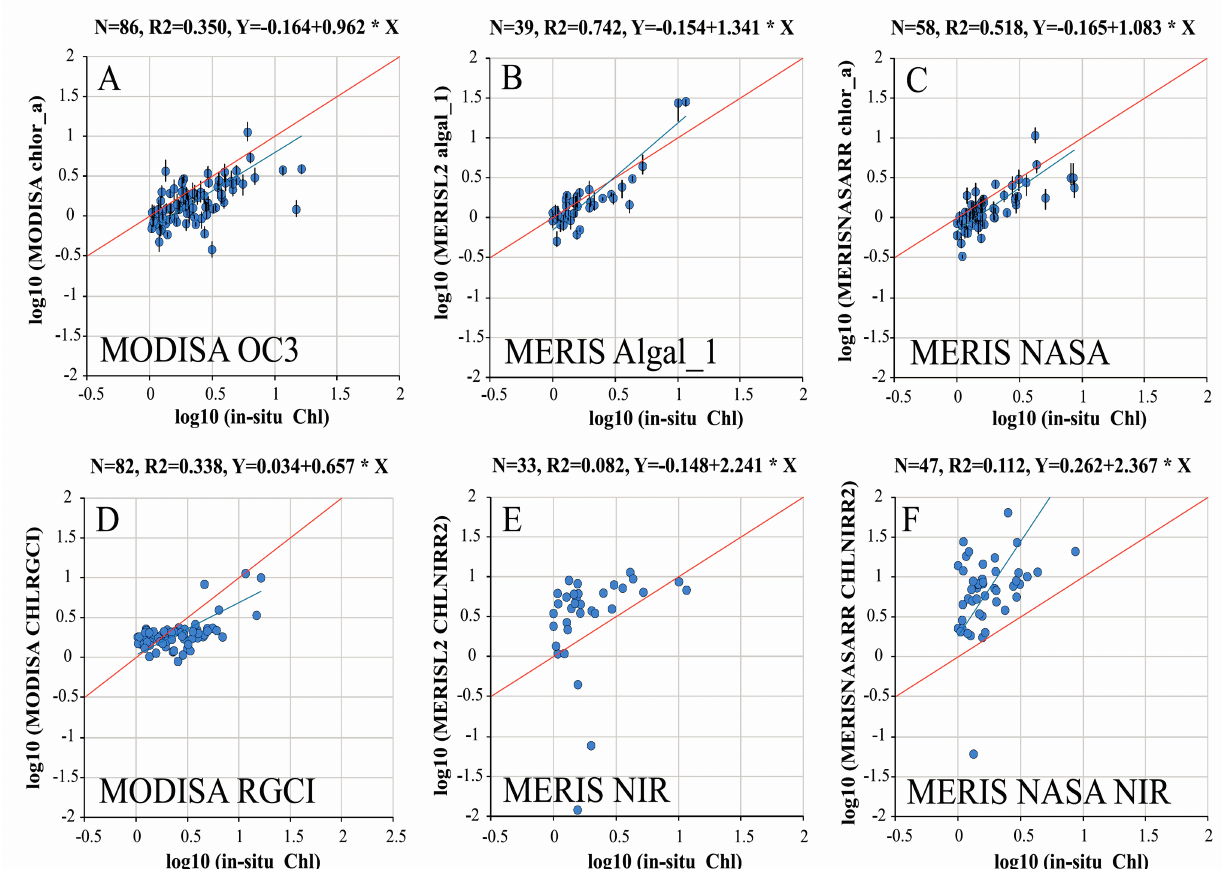
Figure 5. Chlorophyll-a match-ups with in situ Chla ≥ 1 mg m − 3 using standard algorithms ( top ) and specialized (high-Chla) algorithms ( bottom ). ( A ) MODISA OC3; ( B ) ESA MERIS algal_1; ( C ) NASA MERIS; ( D ) MODISA Red-Green-Chlorophyll Index (RGCI); ( E ) MERIS Rrs_709/Rrs_665 applied to ESA MERIS Level-2 data;